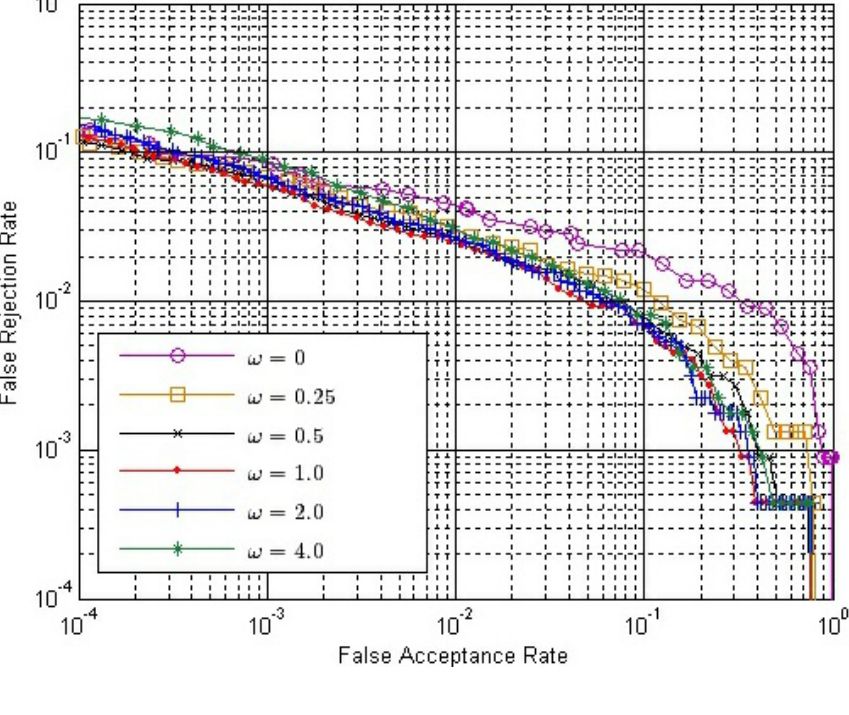
Figure 10. ROC of the final match score with different ω values, where both S E and S C are calculated by Strategy IS-2 and S O is calculated by Strategy OS-1.